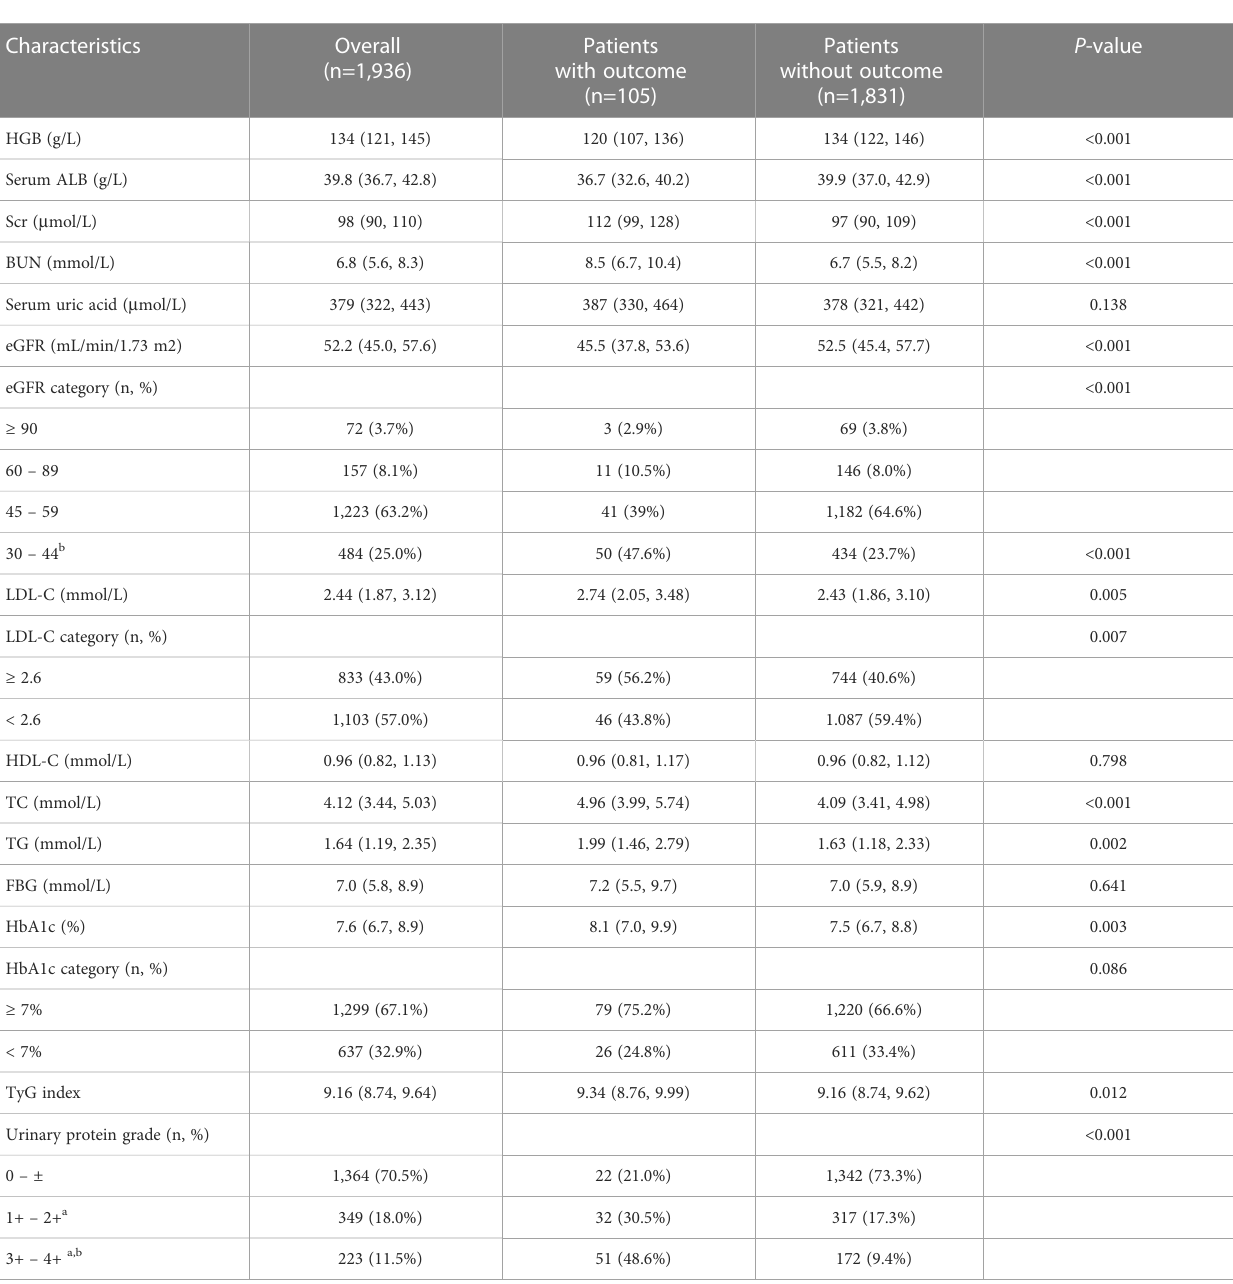
on the basis of model 3, the positive correlation between the TyG index and ESRD remained signi fi cant (HR = 1.49, 95% CI 1.12-1.99, P = 0.006). The details of the covariates were presented in Supplementary Figure 1 and Supplementary Table 1. In summary, the TyG index was an independent predictor for ESRD in patients with T2DM and CKD. As shown in Figure 2, we utilized the RCS curve to model and depict the relationship between baseline TyG index and the risk of ESRD in patients with T2DM and CKD, which demonstrated that the patients with TyG index ≥ 9.5 had a relatively higher risk for ESRD. So we chose a cut-off value of 9.5 and categorized